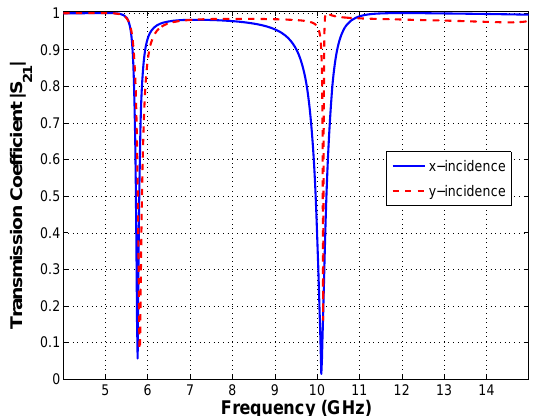
Figure 10: Transmission coefficient for the NB-SRR of Fig. 9, for the x - and y -incidence, respectively. The axes conven- tion is the same as that established in Fig. 1.